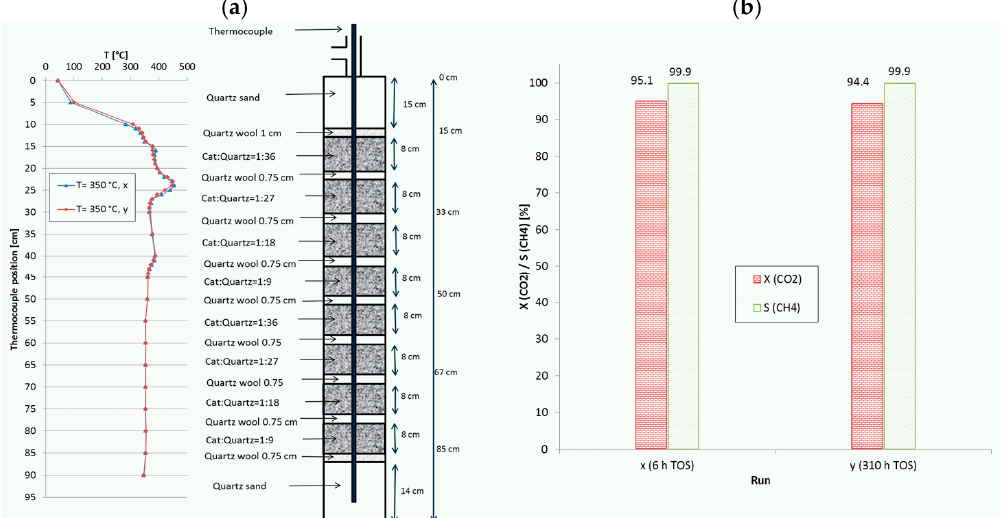
Figure 10. ( a ) Recorded temperature profiles for methanation on 18Ni/Al 2 O 3 in a reactor with 8 fixed-beds. ( b ) CO 2 conversion and CH 4 selectivity in dependence of TOS (catalyst:quartz varied from 1:36 to 1:9; 280 mL total; GHSV = 20,000 h − 1 ; CO 2 :H 2 :N 2 = 1.8:7.2:1; 10